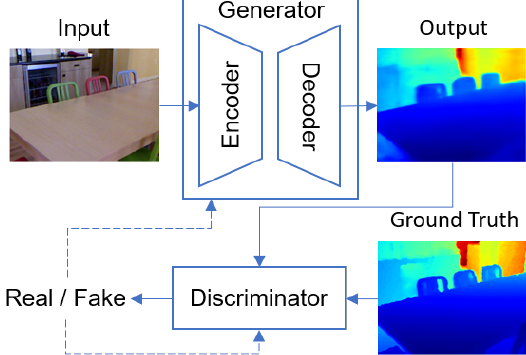
Figure 1. An overview of our encoder-decoder framework. The dashed line refers to the feedback coming from the output of the